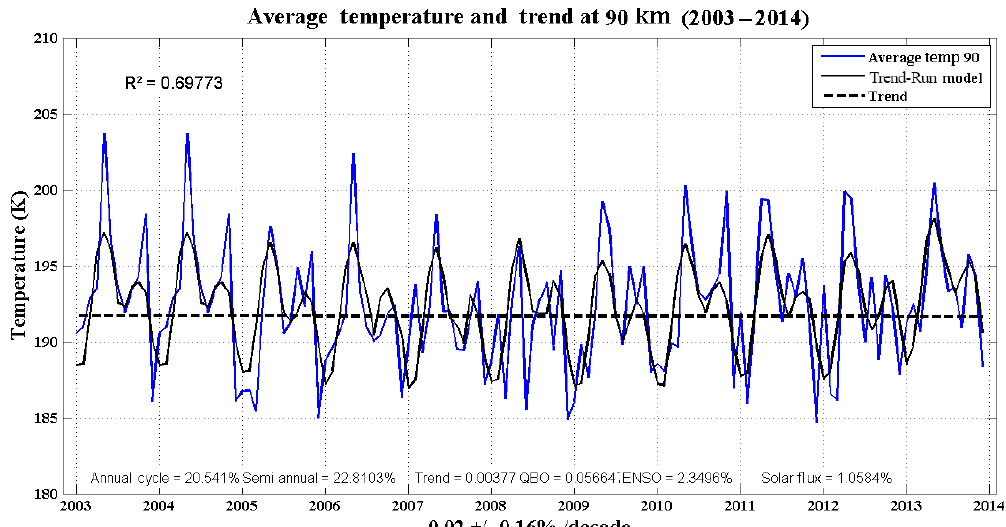
Figure 7. Time evolution of monthly averaged temperature values at 90km height over Santa Maria, within a ± 7.5 ◦ grid. The obtained linear trend is − 0.02 ±− 0.16%Kdecade − 1